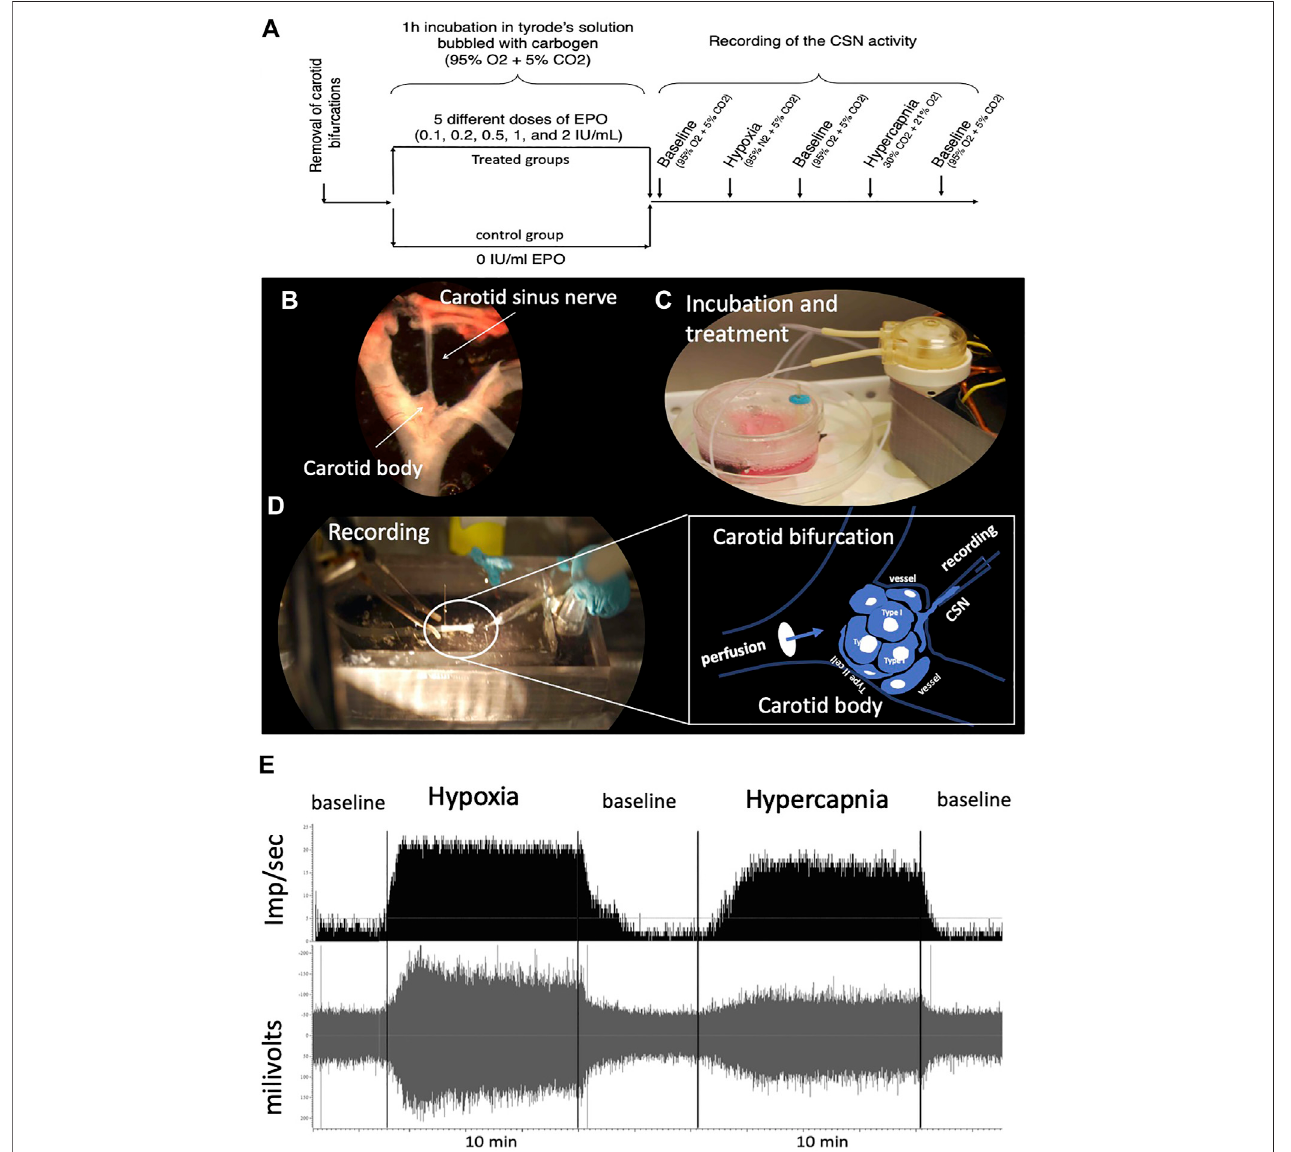
FIGURE 1 | (A) Schematic representation of the experimental design. One EPO concentration per experimental group was used. (B) “ en bloc ” dissection of the carotid bifurcation containing the carotid body and the carotid sinus nerve (CSN). (C) An electric peristaltic minipump was used to perfuse the carotid bifurcation into a tyrode solution during incubation of the sample with (or without, control) EPO. (D) The carotid bifurcation was catheterized during the recording of the CSN activity; The framed diagram is a schematic representation of the perfusion system of the CB by catheterization of the carotid bifurcation and the recording of the activity of the CSN through a suction electrode. (E) typical recording of CSN activity under baseline, hypoxic and hypercapnic conditions.